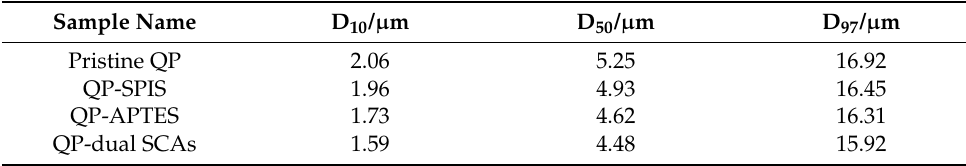
Figure 5. Morphology of the as ‐ obtained samples. Photographs of the ( a ) pristine sample and those of ( b ) the samples modified by 2% APTES and 1% SPIS. SEM images of the ( c , d ) pristine sample and those of ( e , f ) the samples modified by 2% APTES and 1% SPIS. Table 1. D 10 and D 50 of the QP modified by different